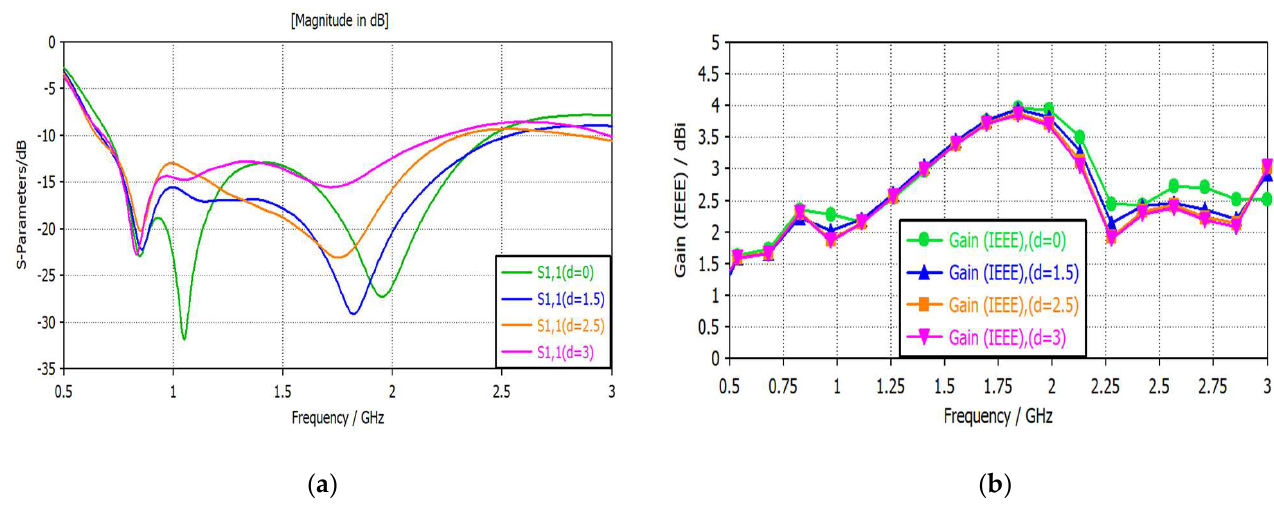
Figure 6. ( a ) Return losses vs. frequency for different values of d in mm; ( b ) Realize gain vs. frequency for different values of d in mm.